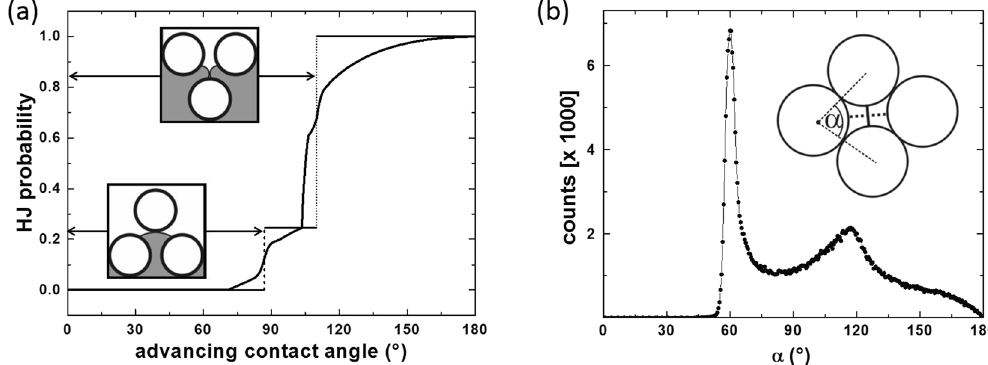
Figure 4. Probability that a pore is being filled by a Haines jump. ( a ) Theoretically derived probabilities as a function of the advancing contact angle θ of the invading phase. The result for ideal tetrahedron pores is shown by the dashed and dotted step function. The result for more realistic tetrahedron pores with one opening is shown by the solid line. ( b ) Distribution of mutual angles between spheres in a random packing, as determined experimentally by X–ray micro-tomography. The strongly dominant peak at α = 60°, together with its ‘mirror image’ at 120°, corroborates that tetrahedral pore with spheres in mutual contact